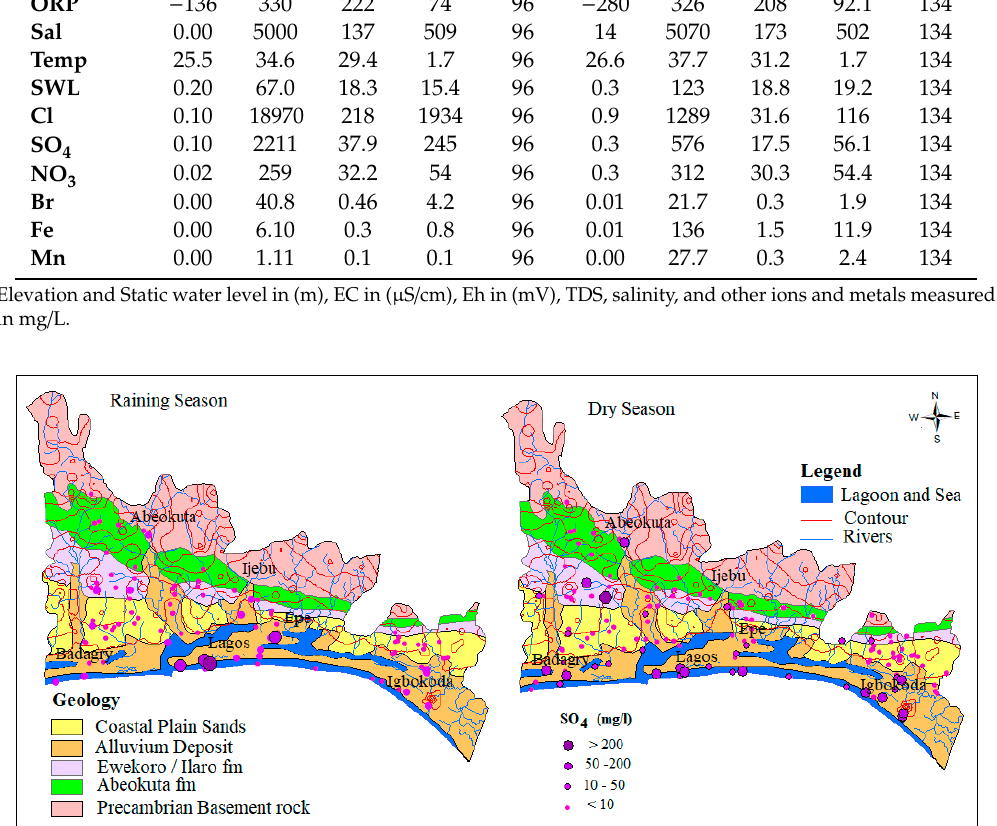
Figure 4. Spatial distribution of SO 42 − across the Eastern Dahomey Basin.